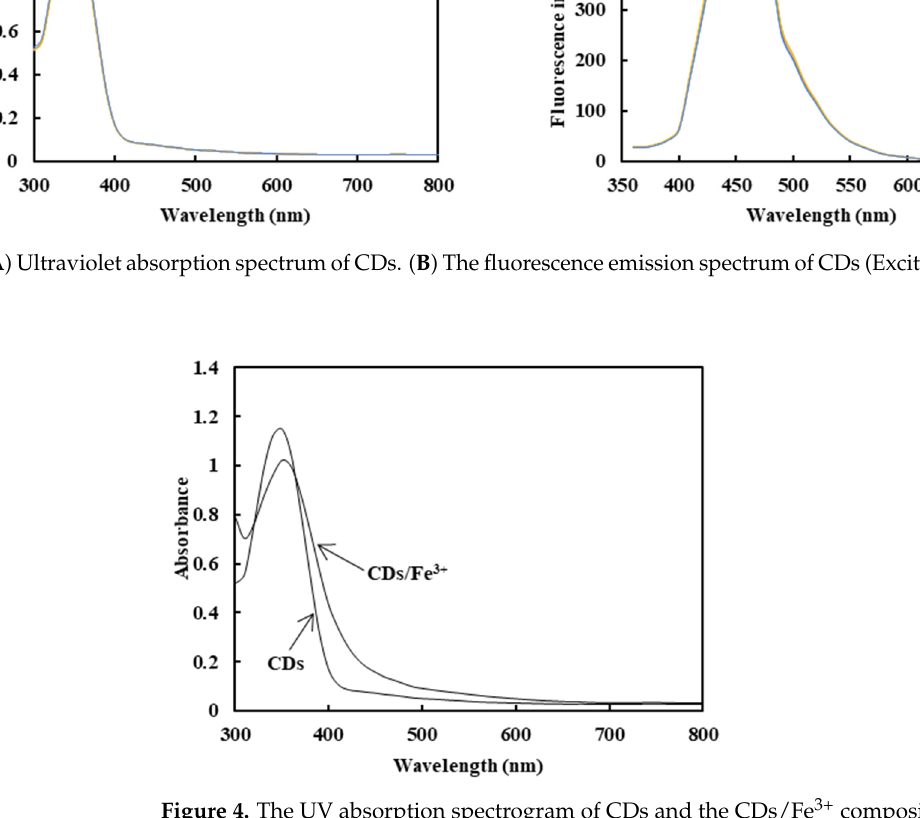
Figure 3. ( A ) Ultraviolet absorption spectrum of CDs. ( B ) The fluorescence emission spectrum of CDs (Excitation wave- length at 360 nm).